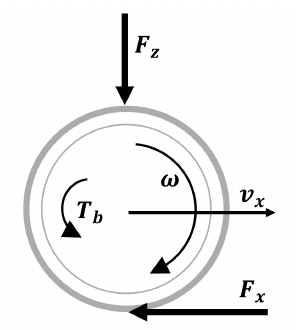
Figure 2. Single-corner vehicle model